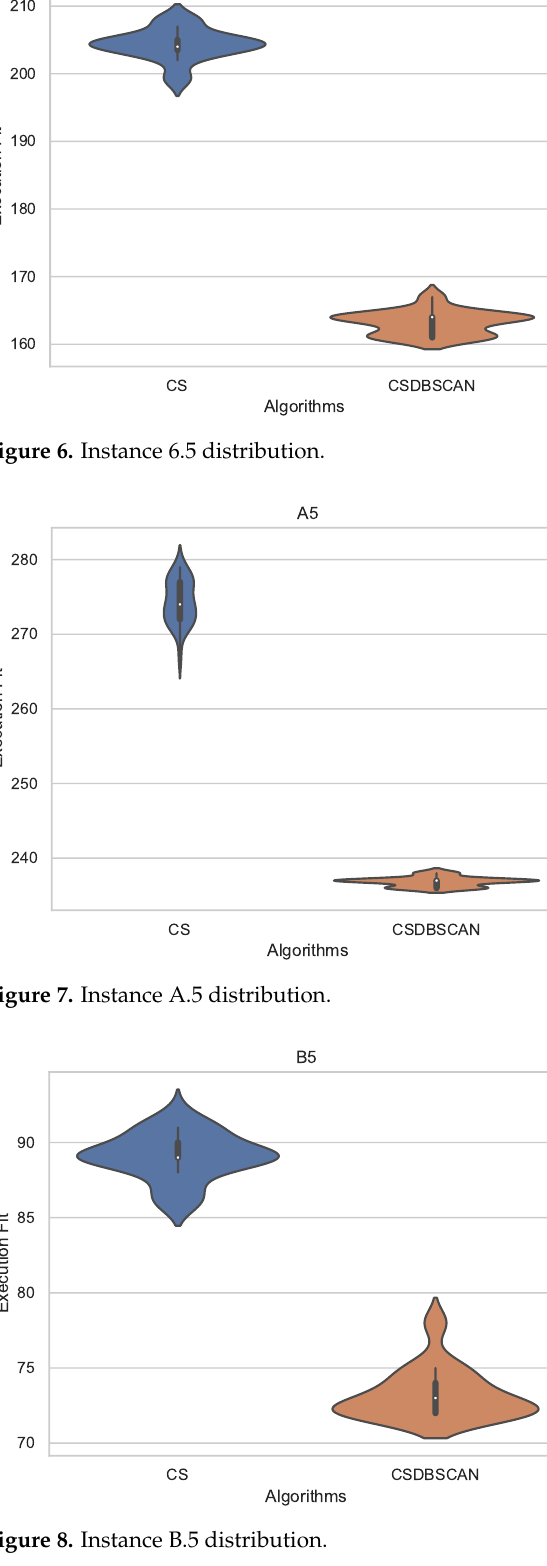
Figure 8. Instance B.5